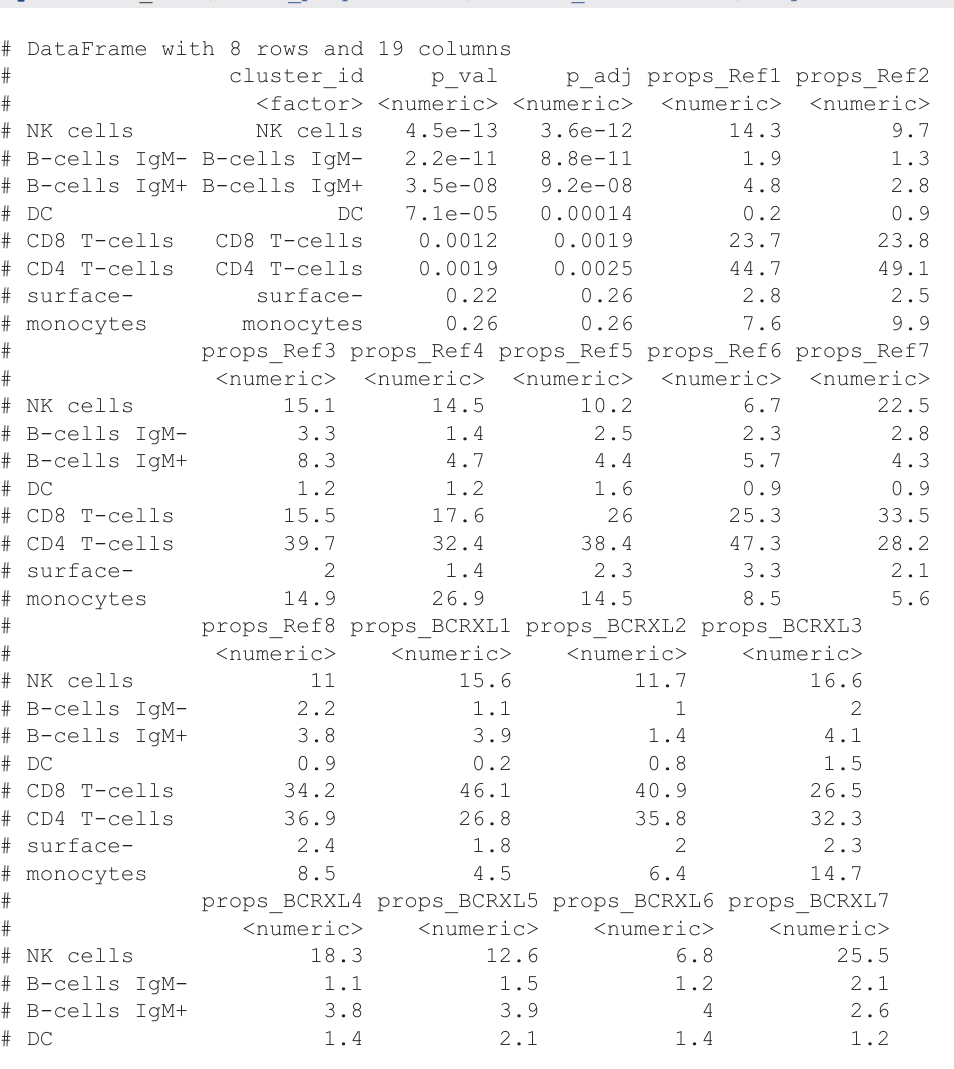
A summary table displaying the results (raw and adjusted p-values) together with the observed cell population proportions by sample can be generated using diffcyt ’s